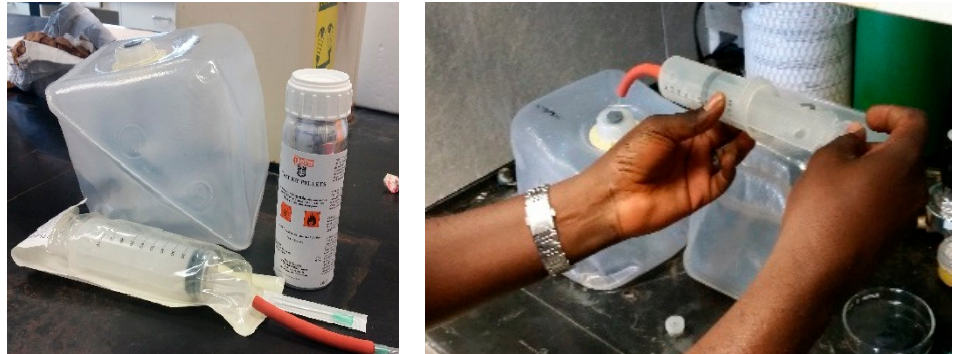
Figure 1. The Detia-Degesch knockdown test kit. The components of the kit (left) are: A collapsible 3.8 L plastic container in which the magnesium phosphide tablet is combined with water to generate about 6000 ppm of phosphine upon reaction; the unopened plastic syringe for use in exposing beetles to gas; and the gas-tight metal container storing the individual sealed tablets of magnesium phosphide. On the right is the transparent plastic syringe with test beetles inside while being loaded with the 6000 ppm phosphine prior to drawing in an equal volume of fresh air to dilute the chamber concentration to about 3000 ppm.